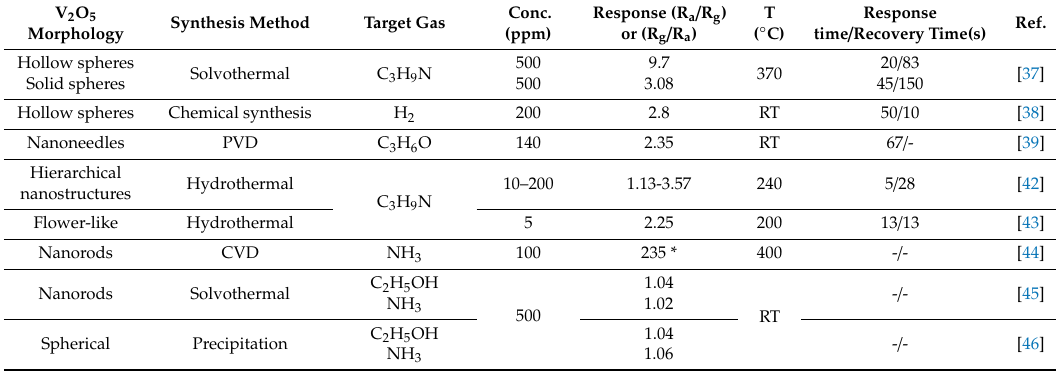
Table 1. Gas sensing properties of pristine V 2 O 5 gas sensors.